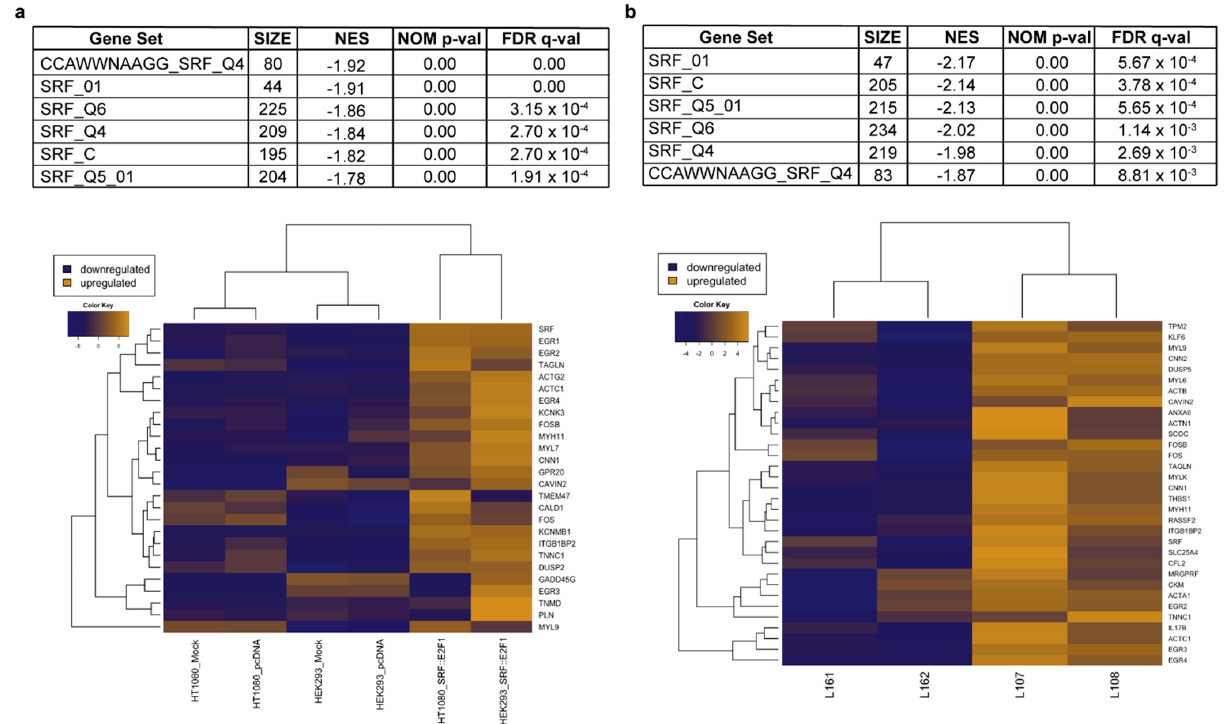
Figure 3. GSEA analyses of transcription factor binding sites’ enrichment in SRF -fusion positive samples. Tables and hierarchical clustering showing that SRF binding sites were among the top scoring enriched gene sets in ( a ) SRF::E2F1 transfected HEK293 and HT1080 cells and ( b ) SRF -fused positive tumors. NES: Normalized Enrichment Score; NOM p -val: Nominal p -value; FDR q-val: False Discovery Rate q-value.